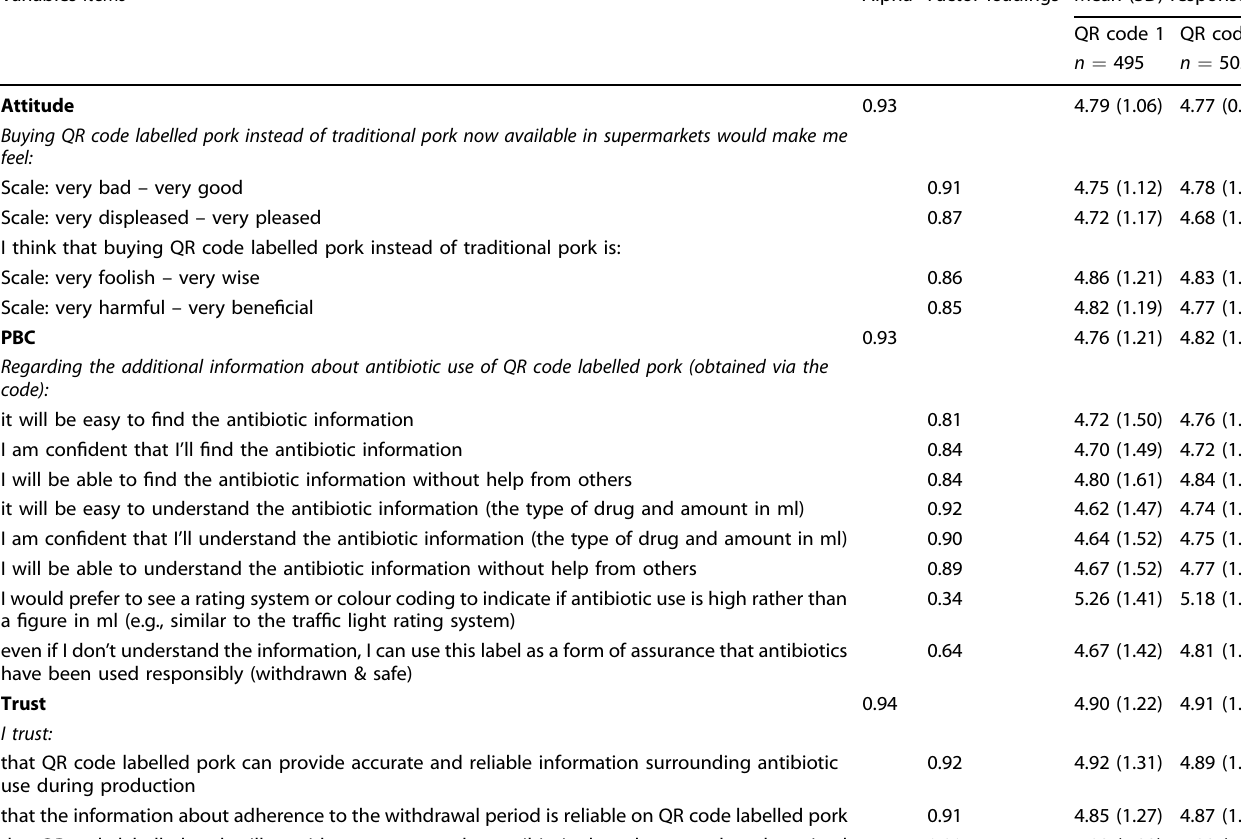
Table 2. Standardised factor loadings, Cronbach ’ s alpha, and Mean (SD) response of questionnaire variables which were scored on a 7-point Likert- type scale (1 = ‘ strongly disagree ” , 7 = “ strongly agree ” ) for each sub-group (QR code one and QR code